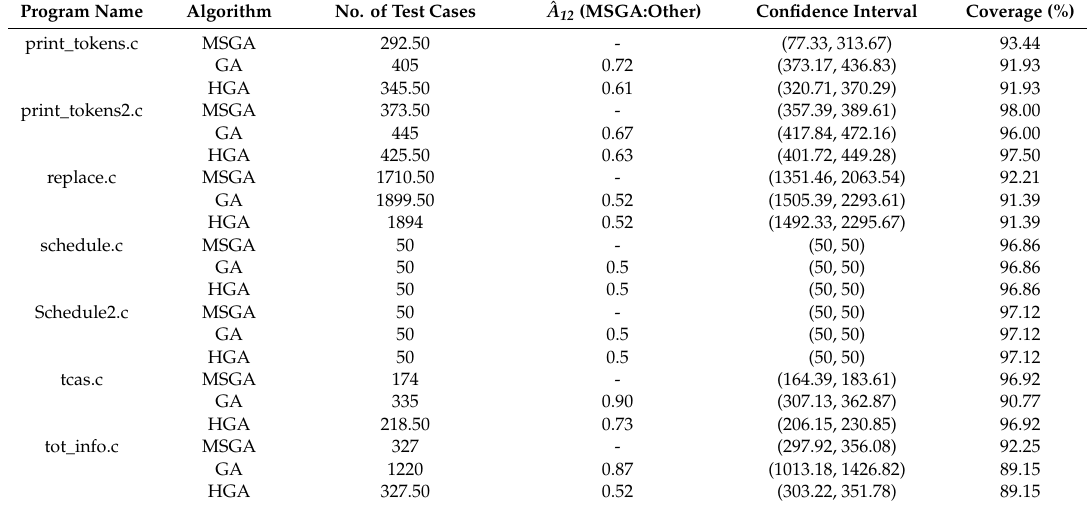
Table 10. Results for generating test cases using MSGA, GA, and hybrid GA (HGA).